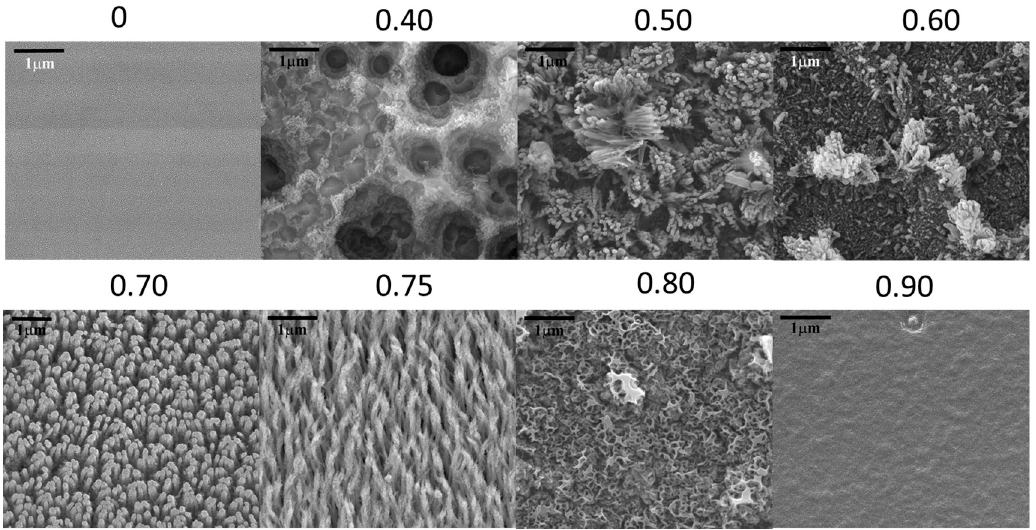
Figure 1. Field emission scanning electron microscopy (FESEM) surface images of CN x :H nanorods obtained at various N 2 :(N 2 + CH 4 ) flow rate ratios.